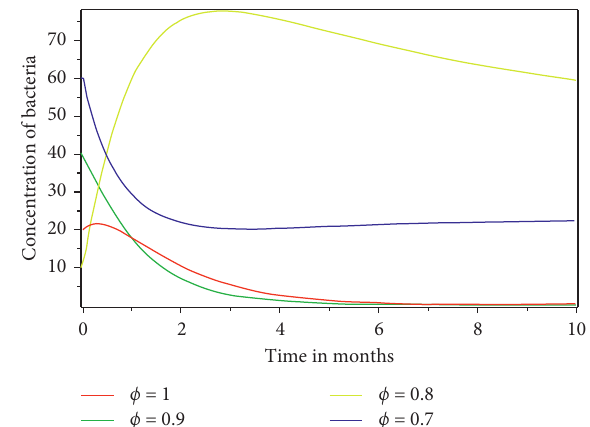
Figure 4: Approximate solution of concentration of bacteria in the environment.